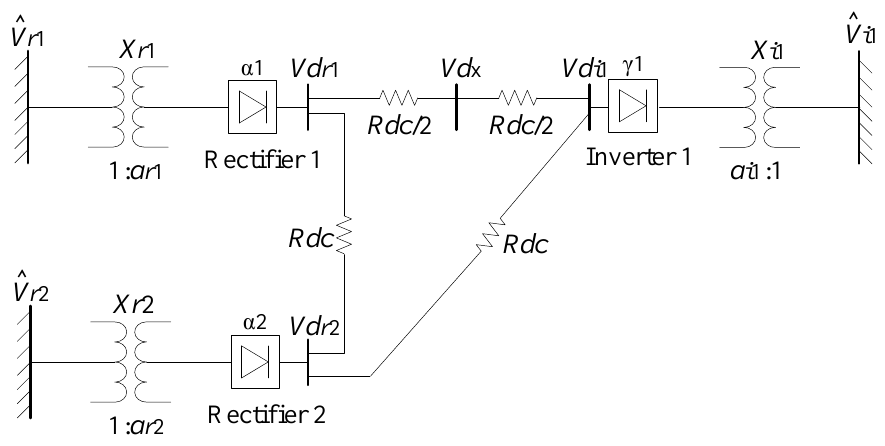
Figure 2. Tutorial Example: System test multiterminal HVDC.